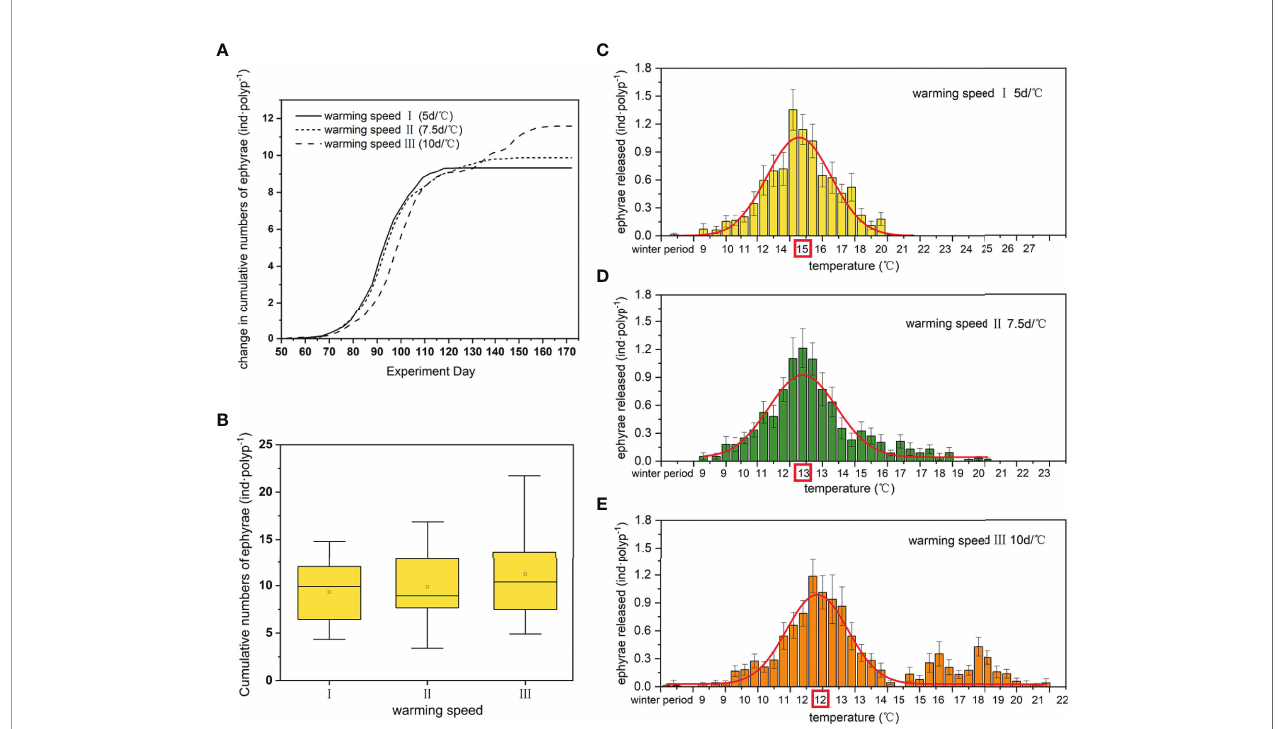
FIGURE 6 | Changes in cumulative numbers of ephyrae at 3 warming speeds (A) , the total numbers of ephyrae released per polyp at 3 warming speeds (B) , and the numbers of ephyrae released as temperature changes at different warming speeds [warming speed I (C) , warming speed II (D) , and warming speed III (E) ]. The solid line in each box in Figure 6B represents the median and the hollow circle represents the mean. The extremities of the box denote the fi rst and the third quartile and the ends of vertical lines denote the range. Any points beyond the ends of vertical line are outliers. Gauss function was used to make the curves in the bar chart (C – E) (parameters: t -test, p < 0.01. model: ANOVA, p < 0.01), and the red box on the horizontal axis of the bar chart indicates the peak temperature of the concentrated release